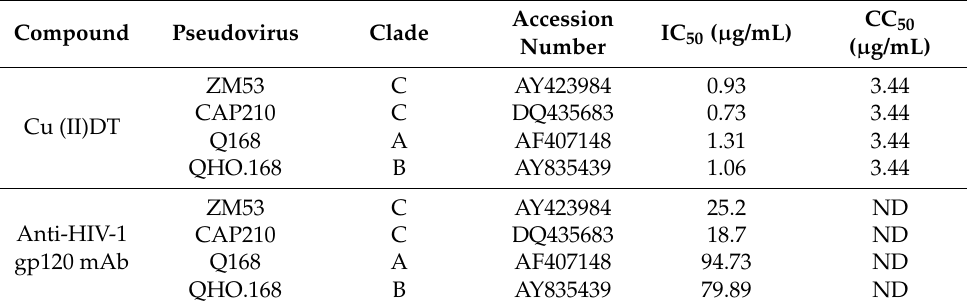
Figure 11. Neutralization assay plot showing the percentage inhibition of different subtypes of HIV-1 Env pseudoviruses with dithiocarbamate complexes of silver(I), bismuth(III), copper(II), indium(III), antimony(III), and gp120 mAb (control) as viral inhibitors. The x axis represents inhibitor concentration in µ g/mL, and the y axis represents percent neutralization. The assay was performed in triplicate. Error bars indicate the mean standard deviations. Table 1. Neutralization efficiency of Cu(II)DT and gp120 mAb against different subtypes of HIV-1 envelope